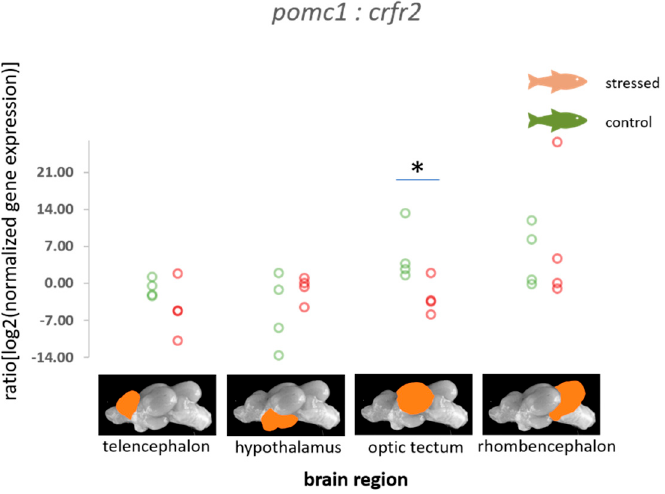
Figure 3. Ratios of the normalized fold expression of pomc1 compared with the expression of crfr2 in each of the four brain parts in the control fish and fish 30 min after the air exposure with 95% confidence intervals of 2.14 to 10.98 for the control and − 5.17 to 0.63 for the stressed fish for values for the optic tectum derived from the adjusted bootstrap percentile (BCa) method; n = 4 per treatment, * = significance according to the Mann–Whitney U tests, p < 0.05.